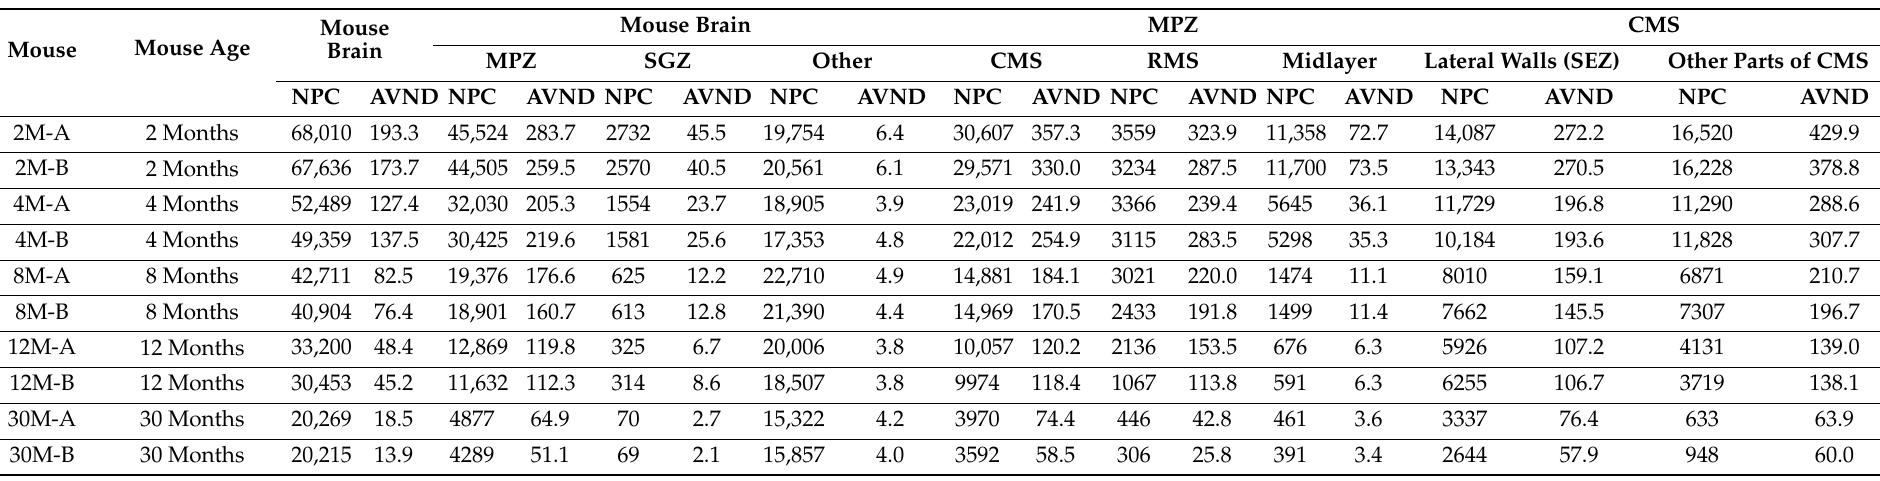
Table 1. Age-related decrease in the number of proliferating cells (NPC) and average volume number density (AVND) of proliferating cells located in the mouse brain and its compartments. Mouse Brain MPZ Mouse Mouse Mouse Age Brain